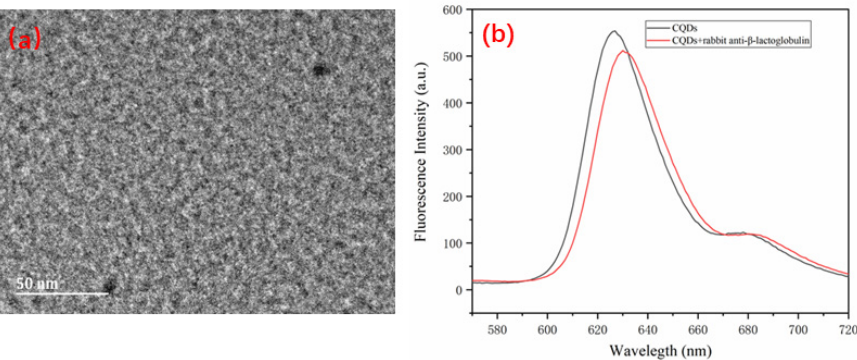
Figure 6. ( a ) High-power transmission electron microscope image of carbon quantum dots; ( b ) Fluorescence spectra of the CQDs before and after conjugation with the β -LG antibody.